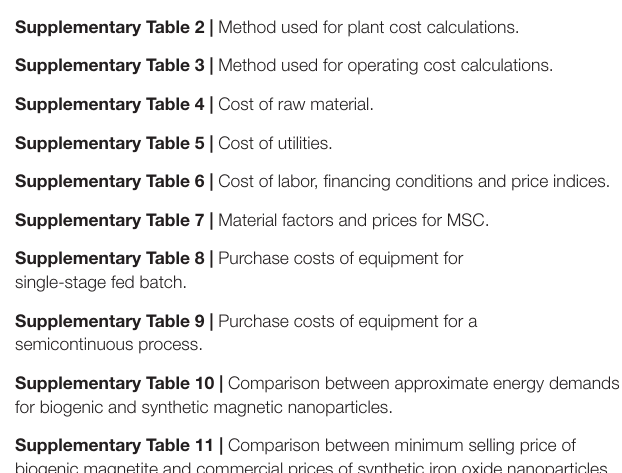
Supplementary Table 2 | Method used for plant cost calculations. Supplementary Table 3 | Method used for operating cost calculations. Supplementary Table 4 | Cost of raw material. Supplementary Table 5 | Cost of utilities. Supplementary Table 6 | Cost of labor, financing conditions and price indices. Supplementary Table 7 | Material factors and prices for MSC. Supplementary Table 8 | Purchase costs of equipment for single-stage fed batch. Supplementary Table 9 | Purchase costs of equipment for a semicontinuous